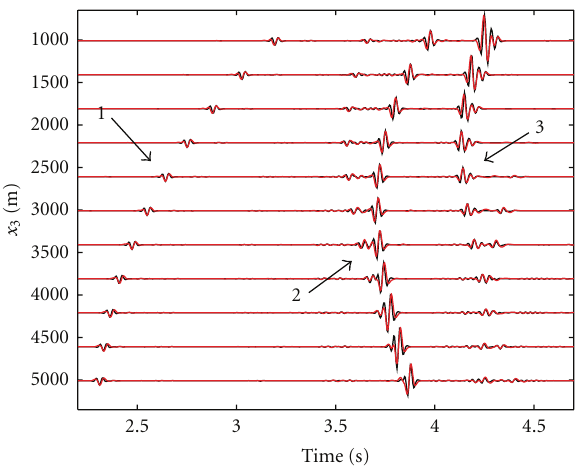
Figure 22: Correlation gather for a virtual source at x A = (15000m,4000m) and a receiver at x B = (15000m,2000m); reflections 1, 2, and 3 are